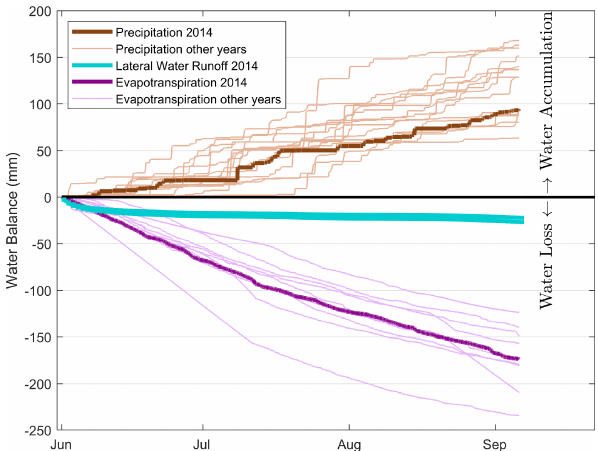
Figure A2. Water balance at the study site between 2 June and 8 September 2014 with cumulative precipitation amounts above zero and cumulative evapotranspiration and the water runoff rate below zero. Cumulative precipitation and evapotranspiration for the years 1998–2018 and 2007–2018, respectively, are shown in lighter colors (with the exception of 2014, which is shown in darker